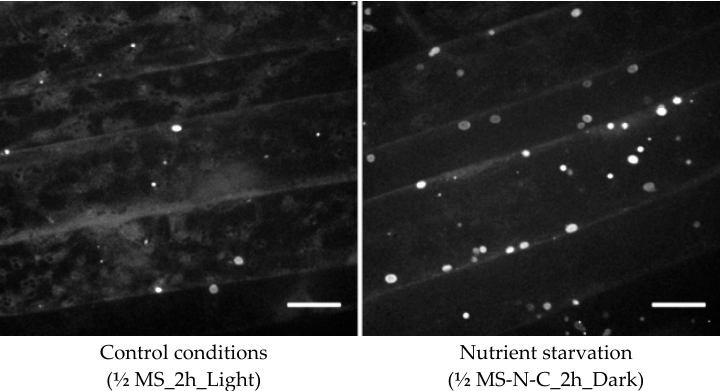
Figure 3. Induction of autophagy by nutrient starvation in the differentiation zone of Arabidopsis root expressing GFP-ATG8. ( Left ) Control conditions with the occurrence of rare GFP-ATG8-labeled structures; ( Right ) after nutrient starvation, an increase in GFP-ATG8-labeled structures after 2 h in a nitrogen- and carbon-deprived medium. Spinning disk microscopy maximum intensity projection (MIP) of 20 µm stacks. Scale bar = 10 µm. Table 1. Advantages and disadvantages of some plant species models used to study autophagy.